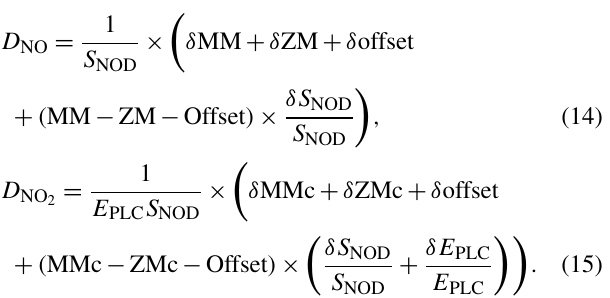
Figure 7. Relative uncertainty of NO (black, day) and of NO 2 (blue, day; red, night) using all measurements (4s) in